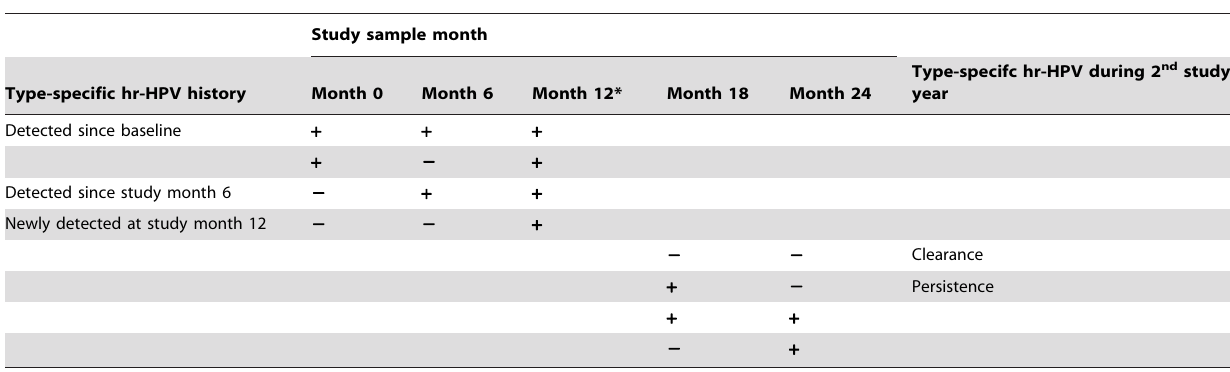
Table 1. Definitions of duration of type-specific hr-HPV